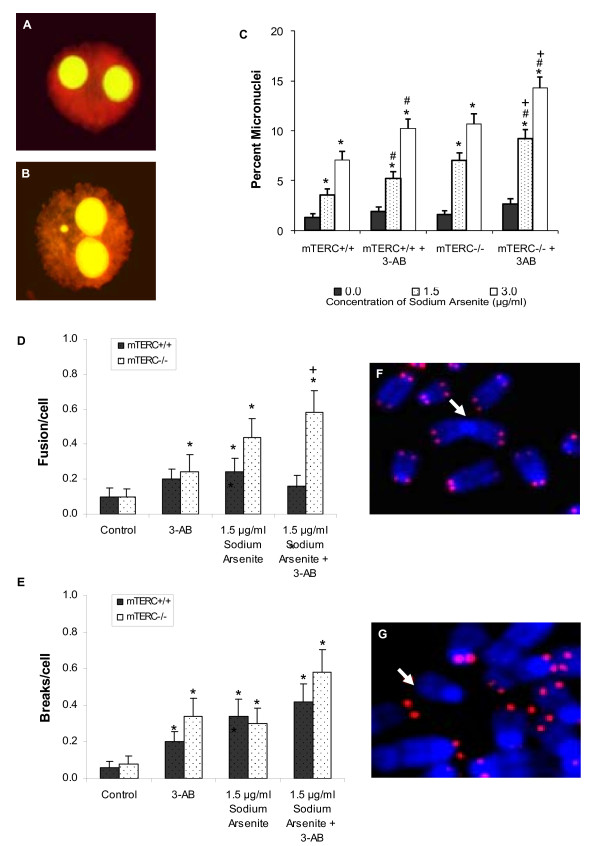
Effects of PARP inhibition in mTERC+/+ and mTERC-/- MEFs on chromosome stability. (A) Acridine orange stained binucleated cell with no MN, indicating no apparent damage. (B) Acridine orange stained binucleated cell with MN from PARP inhibited mTERC-/- MEFs following 24 hour arsenite treatment. (C) Histogram of micronuclei formation, in mTERC+/+ MEFs and mTERC-/- MEFs treated with sodium arsenite [Untreated (Black columns), 1.5 μg/ml (11.5 μM) (dotted columns) and 3.0 μg/ml (23 μM) (white columns)] in the presence or absence of 3-AB. mTERC-/- MEFs displayed a greater extent of MN formation as compared to wild type MEFs at each concentration of arsenite and inhibition of PARP-1 in both MEFs further increased this difference. Frequency of chromosomal aberration such as fusion (D) and breaks (E) per cell as analysed by PNA FISH in mTERC+/+ MEFs (black columns) and in mTERC-/- MEFs (white columns) following treatment with 3-AB and/or sodium arsenite [1.5 μg/ml (11.5 μM)]. Majority of chromosomal breaks and fusions were observed in PARP inhibited mTERC-/- MEFs. Representative images of (F) fusion (arrow) and (G) breaks (arrow) from PARP inhibited mTERC-/- MEFs following 24 hour treatment with arsenite. Data is represented as mean ± SE from three independent experiments. *p < 0.05 when treated cells are compared to respective untreated controls. #p < 0.05 when 3-AB treated cells are compared to respective 3-AB untreated cells in the presence or absence of arsenite. +p < 0.05 when 3-AB treated mTERC-/- cells are compared to 3-AB treated mTERC+/+ in the absence or presence of arsenite treatment.